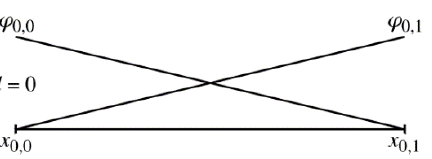
Figure 4. Additional basis functions taking into account boundary values.